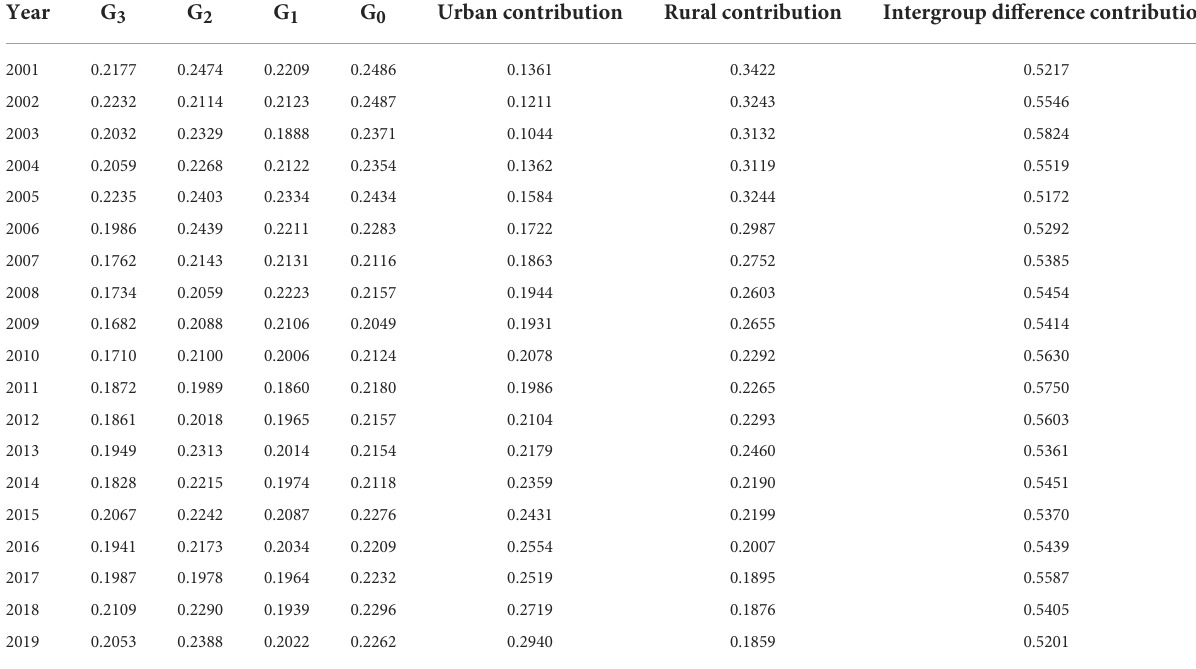
TABLE 5 Urban-rural decomposition of educational inequality in